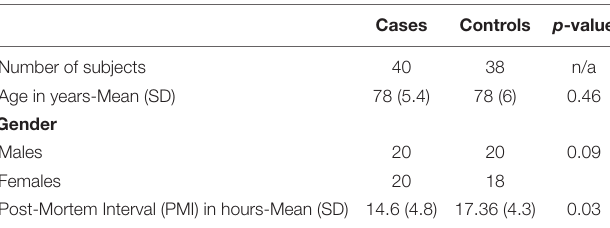
TABLE 1 | Demographic characteristics of Parkinson’s disease cases vs. cognitively healthy control